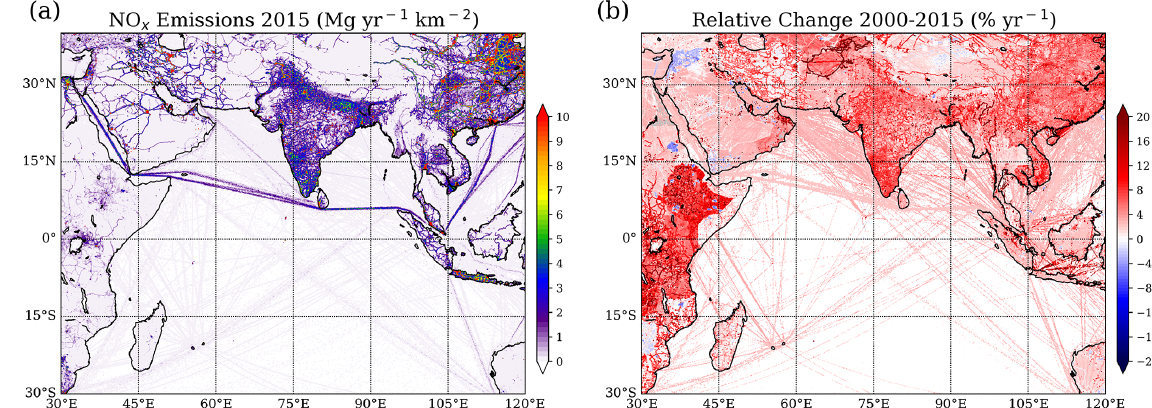
Figure 3. Annual mean NO x emissions for 2015 (a) and relative change with respect to 2000 (b) from EDGAR V5.0_AP.